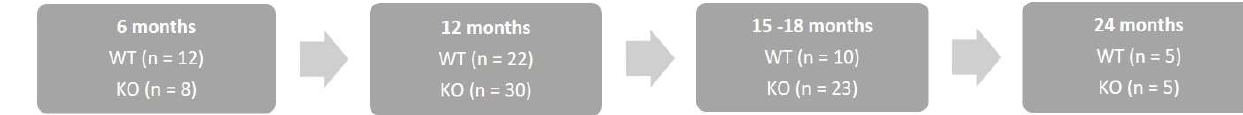
Figure 10. Study design of the long-term follow up of Coch +/+ and Coch −/− mice.